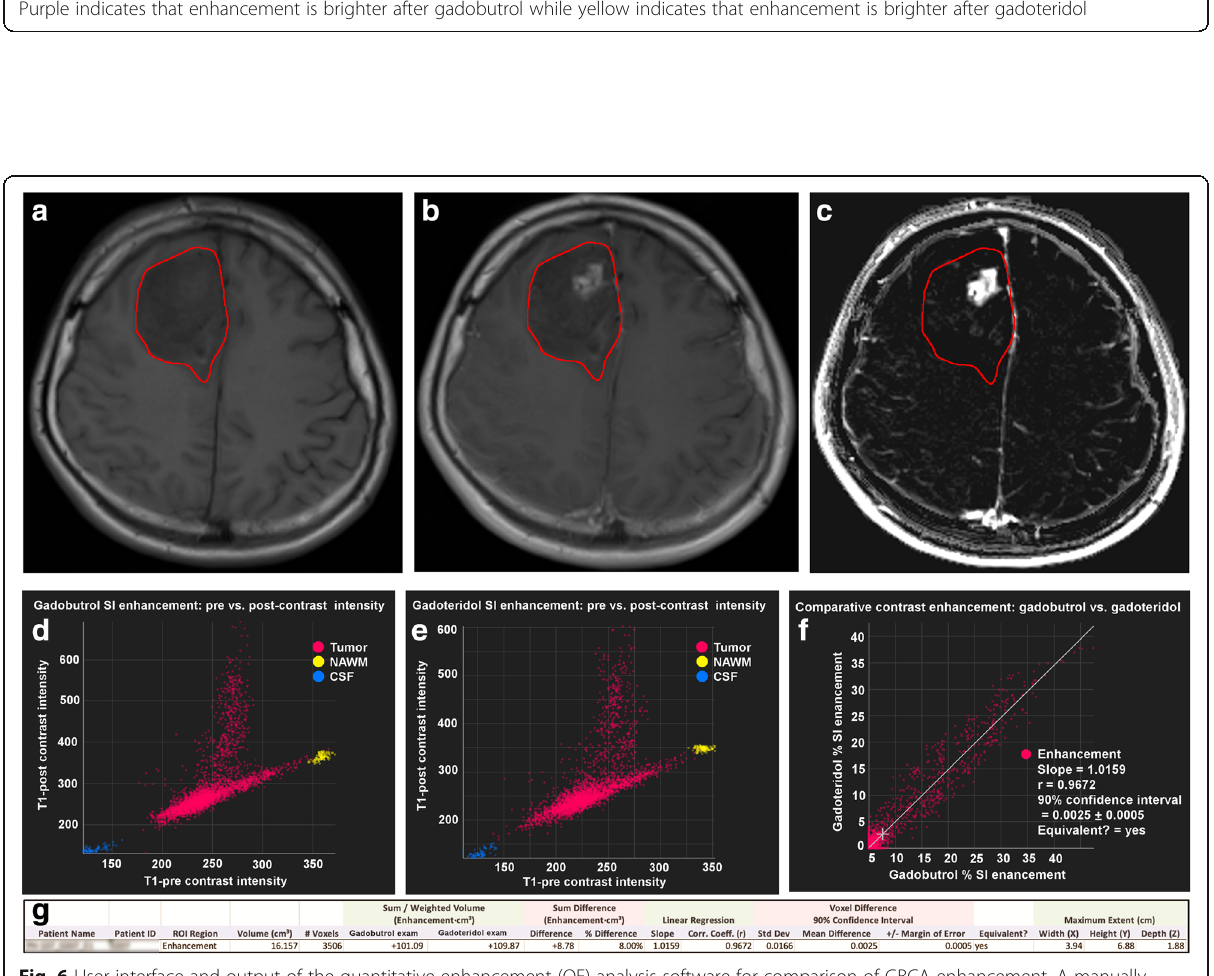
Fig. 6 User interface and output of the quantitative enhancement (QE) analysis software for comparison of GBCA enhancement. A manually delineated region of interest (ROI) that includes the entire enhancing region for both GBCAs is placed on the spatially registered T1-weighted unenhanced ( a ) and contrast-enhanced ( b ) images; the system then automatically calculates the per-ROI sum of QE values for each GBCA (QE map is shown in c ). ROI scatter charts ( d , e ) of voxel enhancement on T1-weighted contrast-enhanced versus T1-weighted unenhanced images reveals the patterns of enhancement for each of the two GBCAs. A scatter chart of the voxel-by-voxel QE value of GBCA 1 versus GBCA 2 ( f ) reveals differences, if any, between the enhancement achieved with each GBCA. Summary statistics ( g ) provide information on the volume, number of voxels, and maximum extent of the lesion as well as details of the QE map voxel enhancement obtained, represented as “ Sum/ Weighted Volume ” for each GBCA and as the “ Sum Difference ” between GBCA 1 and GBCA 2. In this case, the volume of interest was 16.157 cm 3 and 3506 voxels were measured. The per-ROI sum of QE values (enhancement × cm 3 ) was + 101.09 for the first examination with gadobutrol and + 109.87 for the second examination with gadoteridol. The 90% confidence interval of the mean of the differences (0.0025) was within the equivalence zone indicating that the enhancement achieved can be considered equivalent for the two